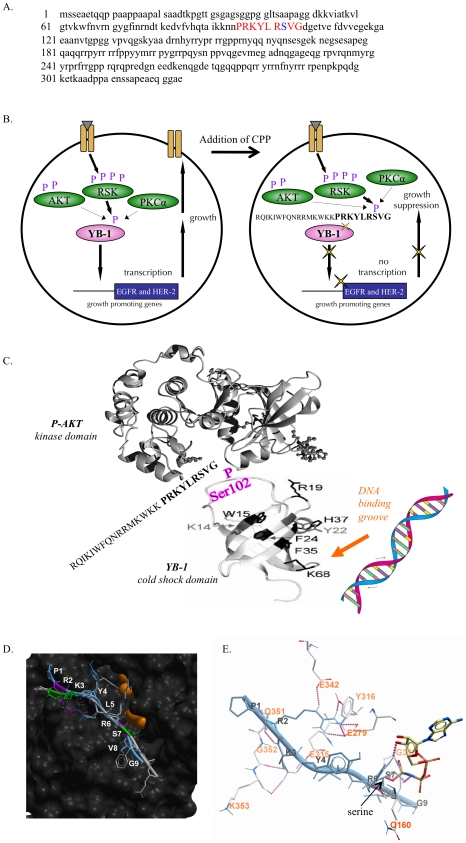
Schematic of the YB-1 peptide inhibitor mode-of-action.
A. We designed a molecular decoy peptide of 9 amino acids (shown in red) that flanked the S102 site (shown in blue) on YB-1. The alignment of the peptide to the endogenous protein is shown. B. The YB-1 cell permeable peptide was designed to function in the following way. In cancer cells receptor tyrosine kinases initiate signaling events that culminate in the phosphorylation of YB-1S102 by RSK, PKCα and/or AKT. Once YB-1 is activated, it promotes the expression of growth receptors such as EGFR or HER-2. The CPP was therefore designed to enter cancer cells and serve as a sink for signaling via RSK, PKCα and AKT, since all of these kinases are potentially capable of phosphorylating YB-1. This CPP mimics the S102 site and thereby accepts the phosphate from adjacent ATP-binding site on the kinase, preventing endogenous YB-1 from becoming activated. In turn, growth-promoting genes are not transcribed, resulting in growth suppression. C. We predict that the S102 site of YB-1 lies in a flexible loop region of the cold-shock domain of YB-1. This region would be able to bind in a lock and key configuration to the peptide-binding site of the kinase domain of RSK, PKCα or AKT (shown). We hypothesize that this interaction promotes a conformational change in YB-1 that allows it to bind DNA and act as a transcription factor. The CPP would therefore, in theory, inhibit endogenous binding of YB-1. D. GSK3β, a known substrate of RSK, was used to further model how the CPP could align into the peptide-binding pocket of RSK, the predominate kinase that phosphorylates YB-1. GSK3β is shown in light grey with the CPP in blue overlaid on top in a peptide-binding pocket of RSK. The alignment was made manually so that the arginine (R) and serine (S) overlapped and would be in exact same conformation. The R and S of GSK3β are shown in green while the R and S of CPP are purple. ATP is shown in orange to demonstrate the relative positioning of the ATP-binding site. E. The CPP theoretically forms 16 H-bonds, shown as purple dashed lines, to the peptide-binding pocket of RSK. The serine site (arrow) is in a position to allow for a hydrogen bond with RSK as well as receive a phosphate group from ATP.